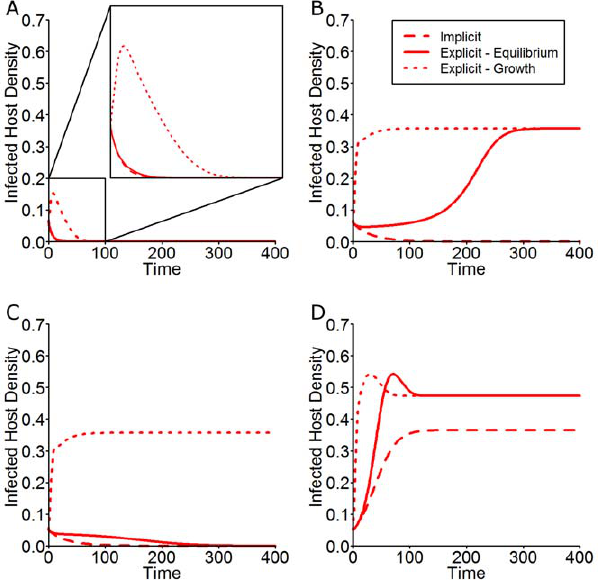
Figure 6. Deterministic realisations for the implicit and explicit models. These plots correspond to the initial conditions in the I 0 - R 0 parameter space shown in Figure 5. (A) For a trajectory starting at point A ( R 0 ~ 0 : 4 , I 0 ~ 0 : 06 ) both models predict the long term extinction of the pathogen but the explicit model predicts invasion of the pathogen for a pre-infection state given by point G ex in Figure 4. (B) For a trajectory starting at point B ( R 0 ~ 0 : 8 , I 0 ~ 0 : 06 ) the implicit model predicts extinction, whereas the explicit model predicts persistence of the pathogen for both pre-infection states. (C) Both models predict the extinction of the pathogen for a system at disease-free equilibrium but the explicit model predicts the long-term persistence of the pathogen for a pre-infection state given by point G ex in Figure 4. (D) Both models predict the persistence of the pathogen sarting from point D ( R 0 ~ 1 : 8 , I 0 ~ 0 : 05 ), regardless of the pre-infection state. The default parameter values are given in Table 2.